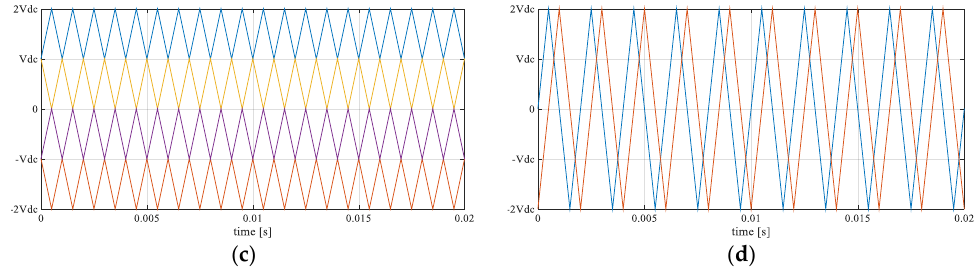
Figure 2. Multicarrier modulation techniques for five-level inverter. ( a ) Sinusoidal Phase Disposition (SPD). ( b ) Sinusoidal Phase Opposition Disposition (SPOD). ( c ) Sinusoidal Alternative Phase Opposition Disposition (APOD). ( d ) Sinusoidal Phase-Shifted (SPS).